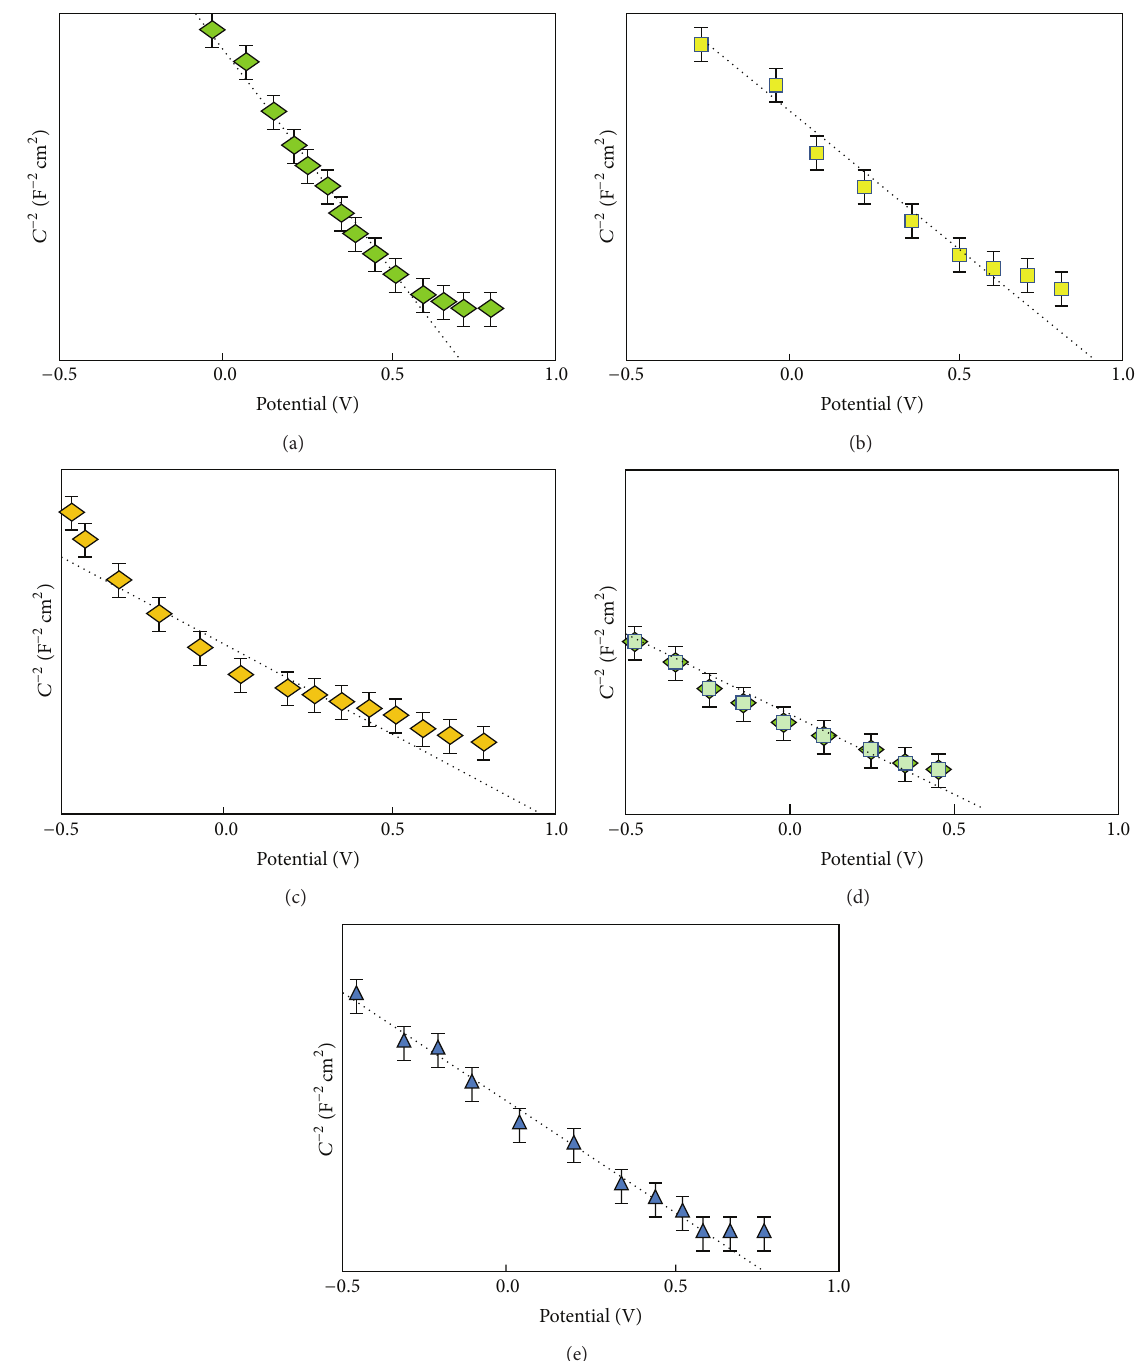
Figure 10: (a) Mott-Schottky plot for CZTS film grown on FTO coated glass substrate and (a) immersed in europium nitrate solution, (b) immersed in oxalic acid aqueous solution, (c) immersed in sodium nitrite aqueous solution, (d) immersed in sodium sulfite aqueous solution, and (e) immersed in formaldehyde aqueous